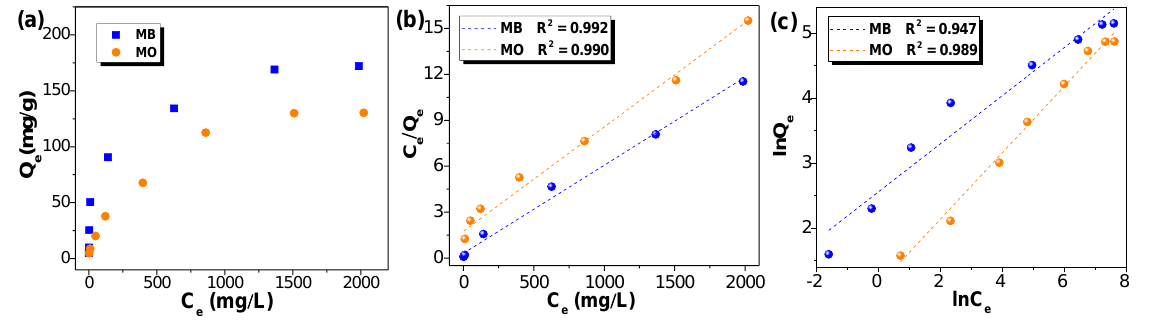
Figure 7. ( a ) Adsorption isotherms for the adsorption of MB and MO by mPVA/AC CG at pH 7. ( b ) The values of C e /Q e against C e based on the Langmuir isotherm model. ( c ) The values of lnQ e against lnC e based on the Freundlich isotherm model. Table 3. The isotherm parameters for the adsorption of MB and MO onto the mPVA/AC CG.